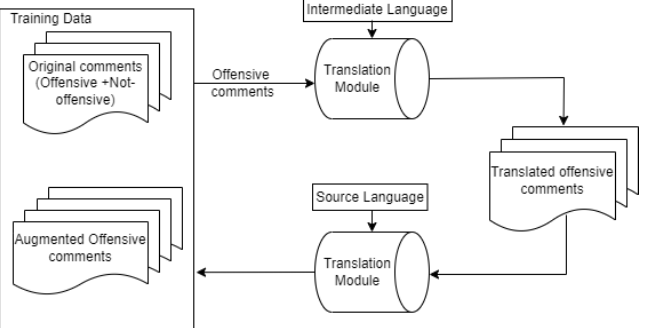
Figure 3. Balancing the dataset using the back-translation method for data